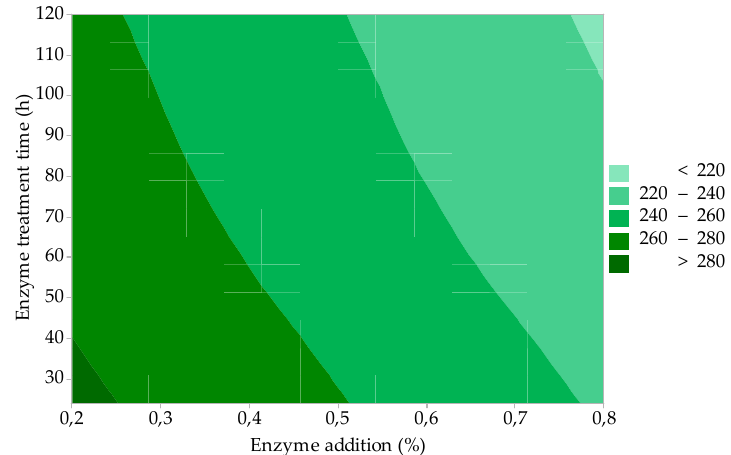
Figure 2. E ff ect of enzyme addition and enzyme treatment time on gelatine gel strength (study of the influence of process